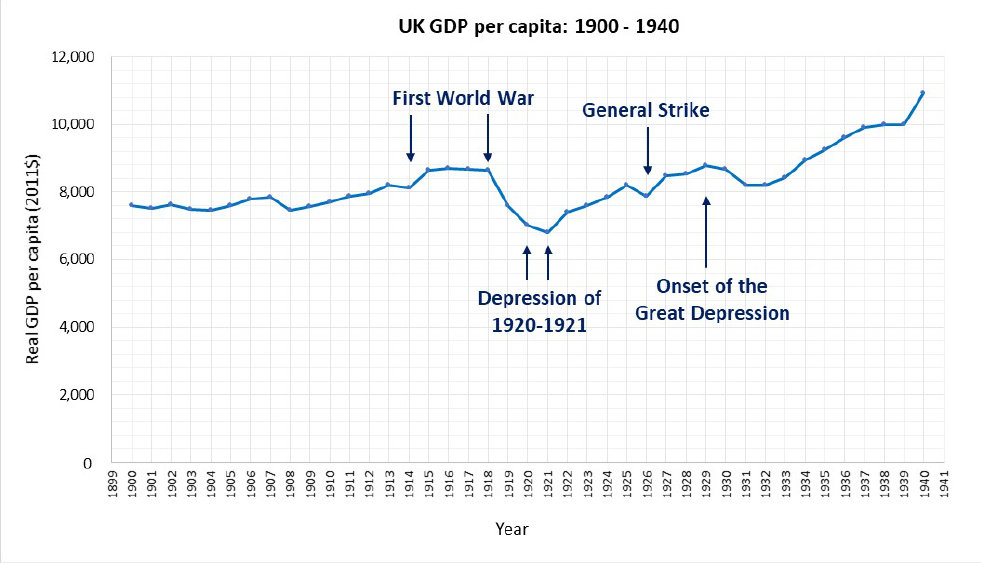
Figure 1. UK GDP per capita from 1900 to 1940, emphasising the crises of the interwar period.